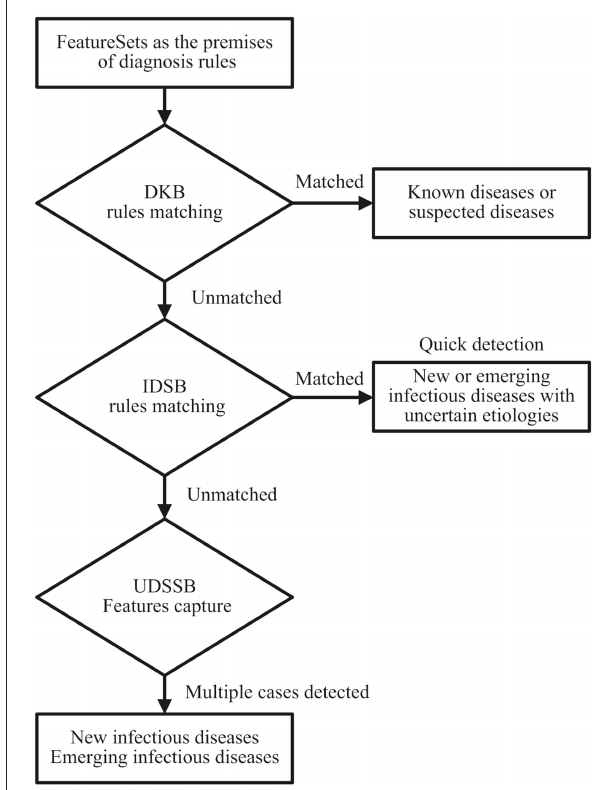
FIGURE 1 | Diagnosis and detection process schematic diagram of the target cases; DKB, Diagnosis Knowledge Base; IDSB, Infectious Diseases Surveillance Base; UDSSB, Unknown Diseases Syndromic Surveillance